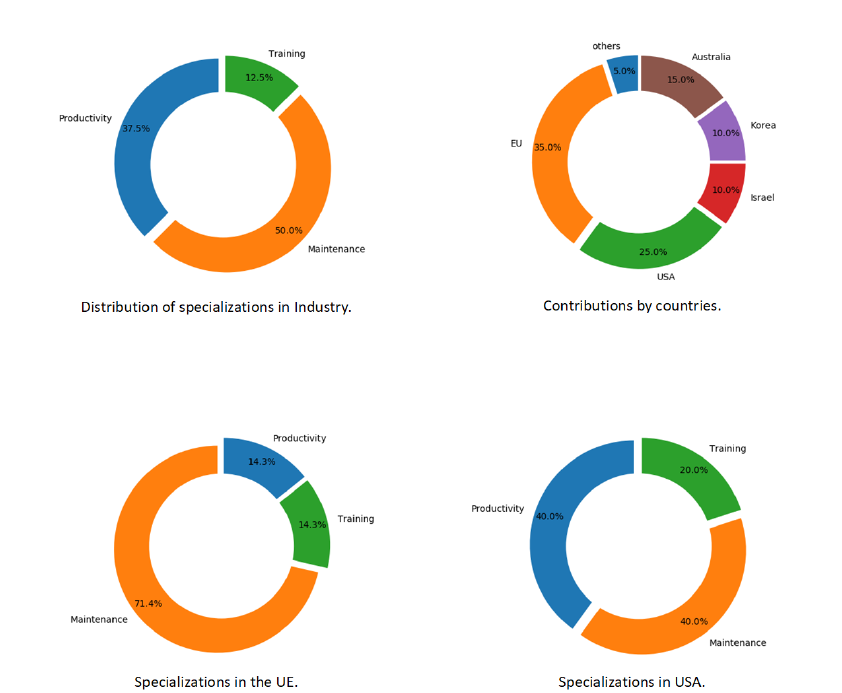
Figure 13. Information about publications on industry: in the top left image is the percentage of publications analyzed in industry. In the top right is the percentage of publications made by countries. In the bottom left is the publications made in the EU, and in the right bottom is the information of publications made in the